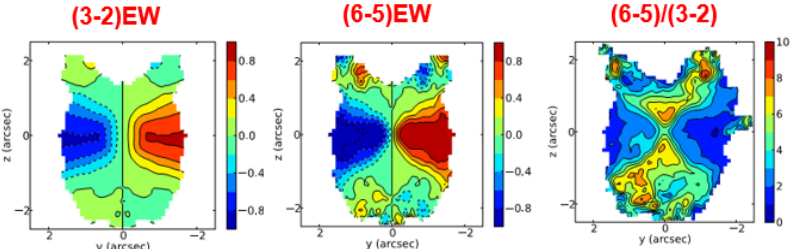
Fig. 3 Red Rectangle: mean Doppler velocity maps (left and centre) and line intensity ratio (right). Fig. 3 (left and centre) displays the mean Doppler velocity maps for each line separately. The East-West asymmetry reveals clearly the rotation of the equatorial region about the star axis. The map of the ratio of the two line intensities, a proxy of temperature, shows evidence for a biconical structure down to very small distances from the central star (Fig. 3 right). We modelled the gas kinematics dividing the velocity fields in two regions. In the polar regions, the lines of field are meridian parabolas joining smoothly with the equatorial region where trajectories are spirals accounting for both rotation and expansion (Fig. 4 left and central). The best fit (Fig. 4 right) gives a surprisingly good description of the data given the crudeness of the